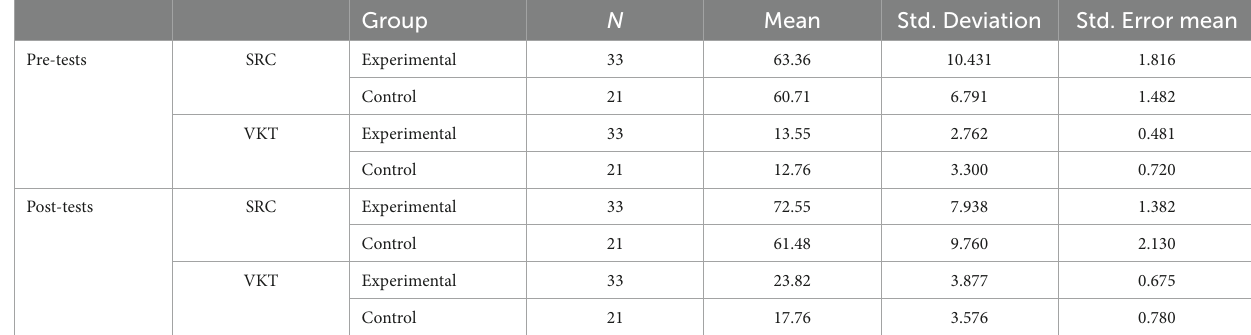
TABLE 1 Descriptive